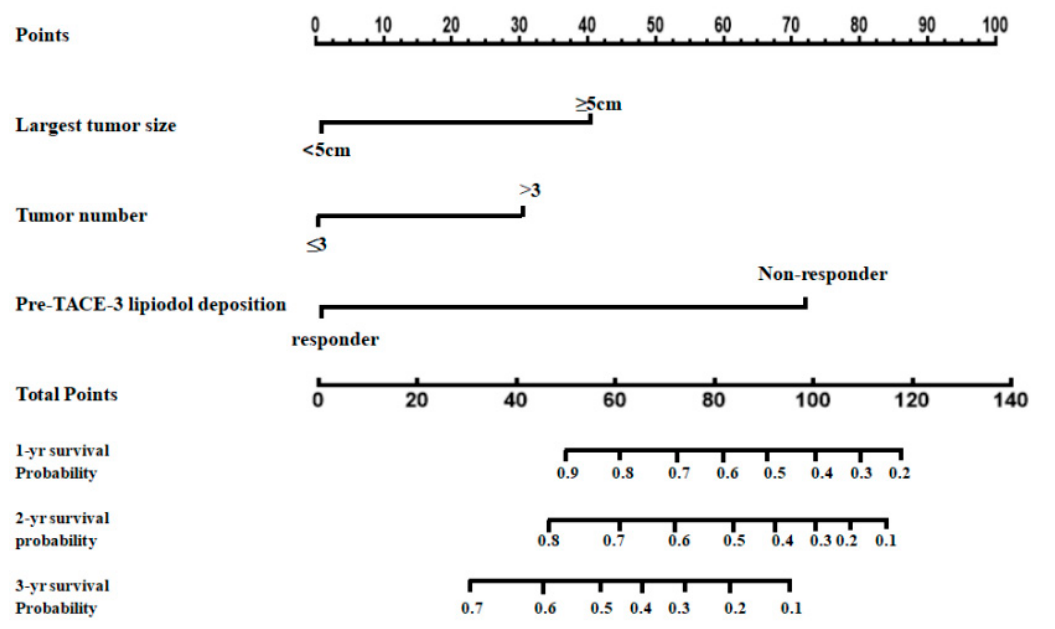
Figure 4. Prognostic nomogram showing the assessment of 1-, 2-, and 3-year survival in patients